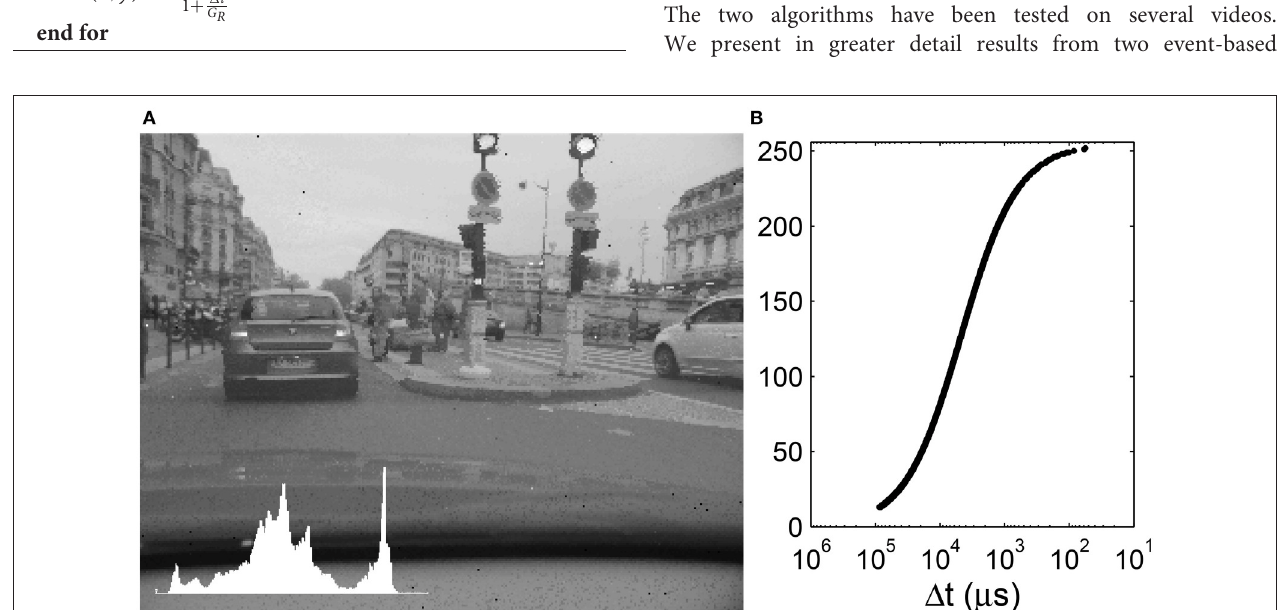
FIGURE 5 | (A) Global tone mapping of a 140 dB input to 256 gray-levels. Inset: Image histogram. (B) Corresponding tone mapping function. The input time differences are plotted on an inverse logarithmic scale while the output gray-levels are plotted linearly.